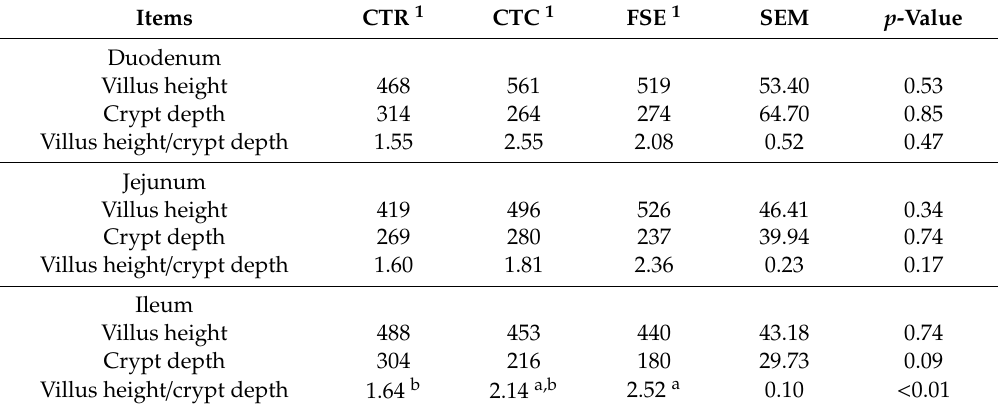
Table 8. E ff ects of Forsythia suspense extract on intestinal morphology of weaned piglets on day 28. Items CTR